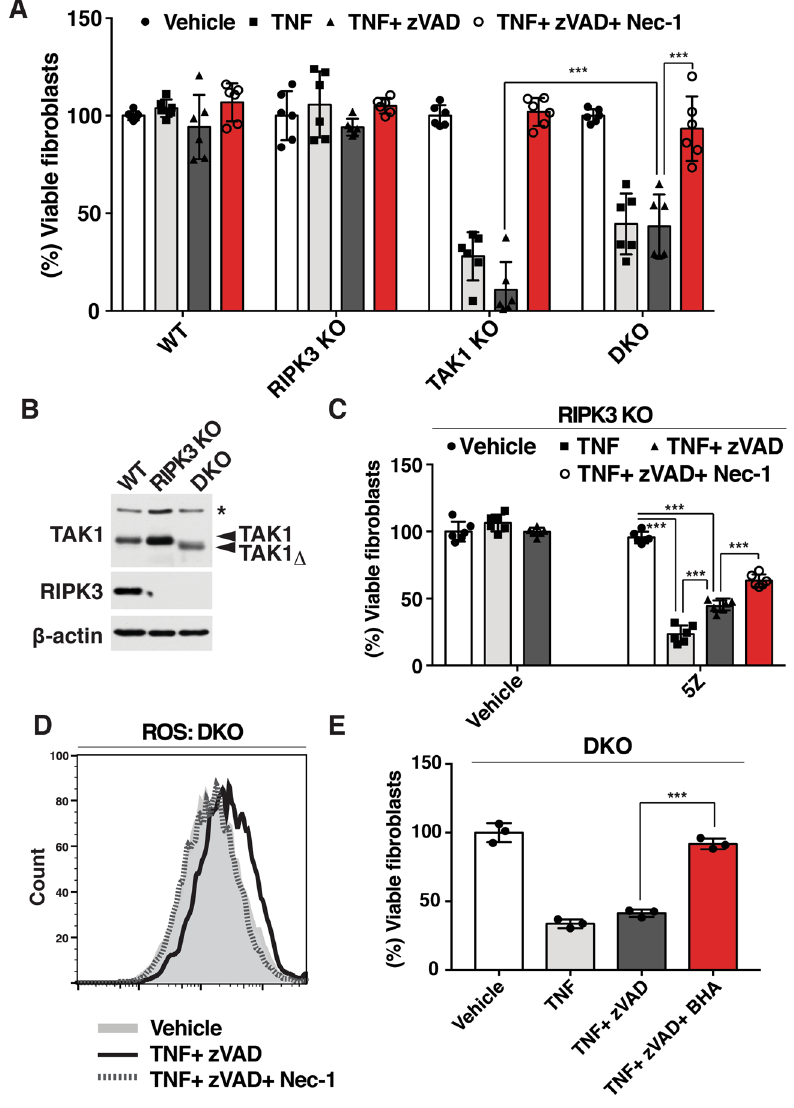
Figure 4. TNF induces RIPK1-dependent noncanonical cell death independent of caspase activity and necroptosis in the absence of TAK1 ( A ) WT, Tak1 -deficient (TAK1 KO), Ripk3 − / − (RIPK3 KO) and Tak1 - deficient Ripk3 − / − (DKO) were pre-treated with vehicle (DMSO) or 20 μ M zVAD + / − 50 µ M Nec-1 for 1 h and stimulated with 20 ng/ml TNF for 24 h. Cell viability was determined by crystal violet assay. Data are the result of 3 independent experiments and show mean percentages + / − SD. NS, not significant; *** p-value < 0.001; two-way ANOVA. ( B ) WT, RIPK3 KO and DKO fibroblasts were analyzed by immunoblotting. Tak1 -deficient fibroblasts expressed a truncated nonfunctional form of TAK1 (TAK1 Δ ). β -actin is shown as a loading control. ( C ) RIPK3 KO fibroblasts were pretreated with 20 μ M zVAD, 50 µ M Nec-1 and/or 5Z-7-oxozeaenol for 1 h and stimulated with 20 ng/ml TNF for 24 h. Data are the result of at least 3 independent experiments and show mean percentages + / − SD. NS, not significant; *** p-value < 0.001; one-way ANOVA. ( D ) DKO fibroblast were pretreated with 20 µ M zVAD and/or 50 µ M Nec-1 for 1 h and stimulated with 20 ng/ml TNF. ROS were analyzed by CM-H 2 DCFDA at 6 h post TNF stimulation. The result shown is representative result of 3 independent experiments. ( E ) DKO fibroblasts were pre treated with 100 µ M BHA and/or 20 µ M zVAD for 1 h and stimulated with 20 ng/ml TNF for 24 h. Cell viability was determined by crystal violet assay. Data are the result of 3 independent experiments and show mean percentages + / − SD. *** p-value < 0.001; one-way